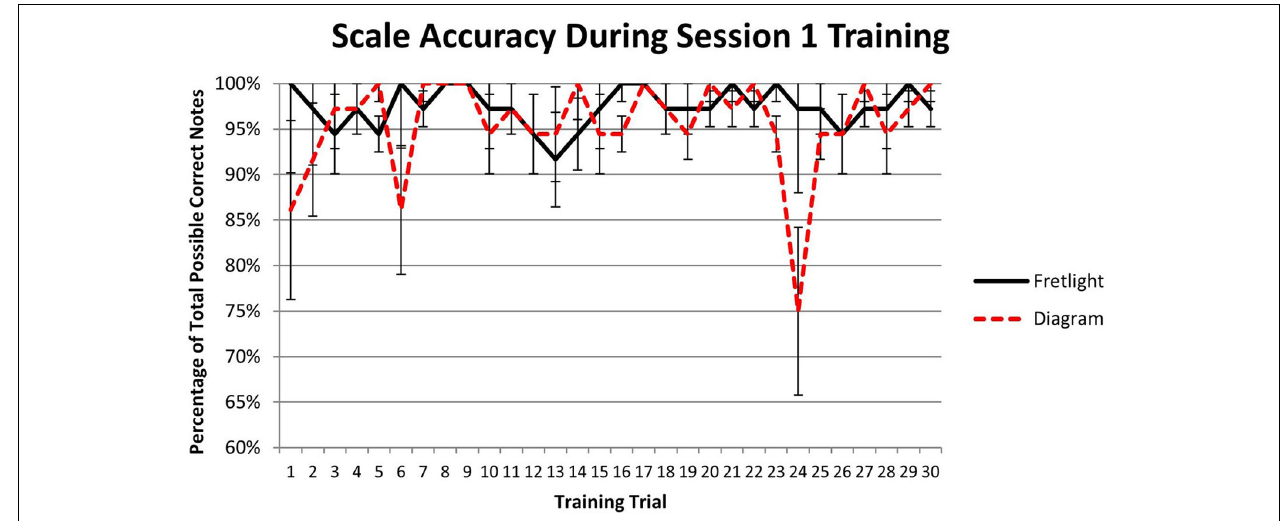
FIGURE 6 | Experiment 2 results regarding scale accuracy during session 1